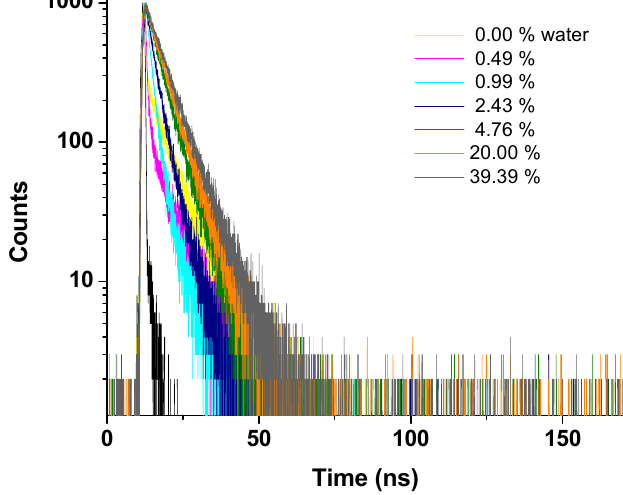
Figure 9. Fluorescence decay curves of 8 in dioxane with different amounts of water. Table 8. Fluorescence lifetimes of naphthalimides 7 and 8 in dioxane/water system.